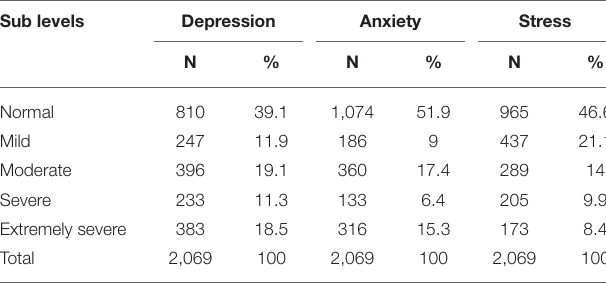
TABLE 2 | Descriptive statistics of depression, anxiety, and